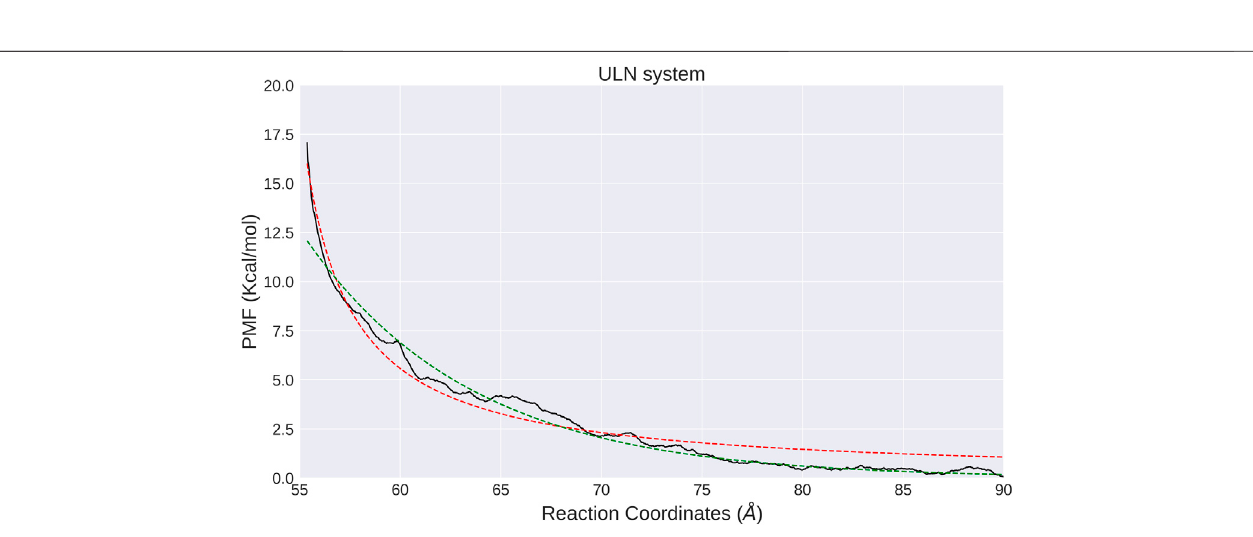
FIGURE4| PMF calculatedfrom umbrellasampling intheULN systemalong thedistancebetweentwo nucleosomes (black solidlines). The fi ttedexponential and shifted Coulomb potential functions are shown as red dotted line and green solid line, respectively.